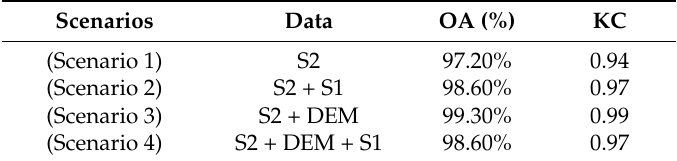
Table 8. Results of forestland extraction based on RF analysis for the four tested scenarios.